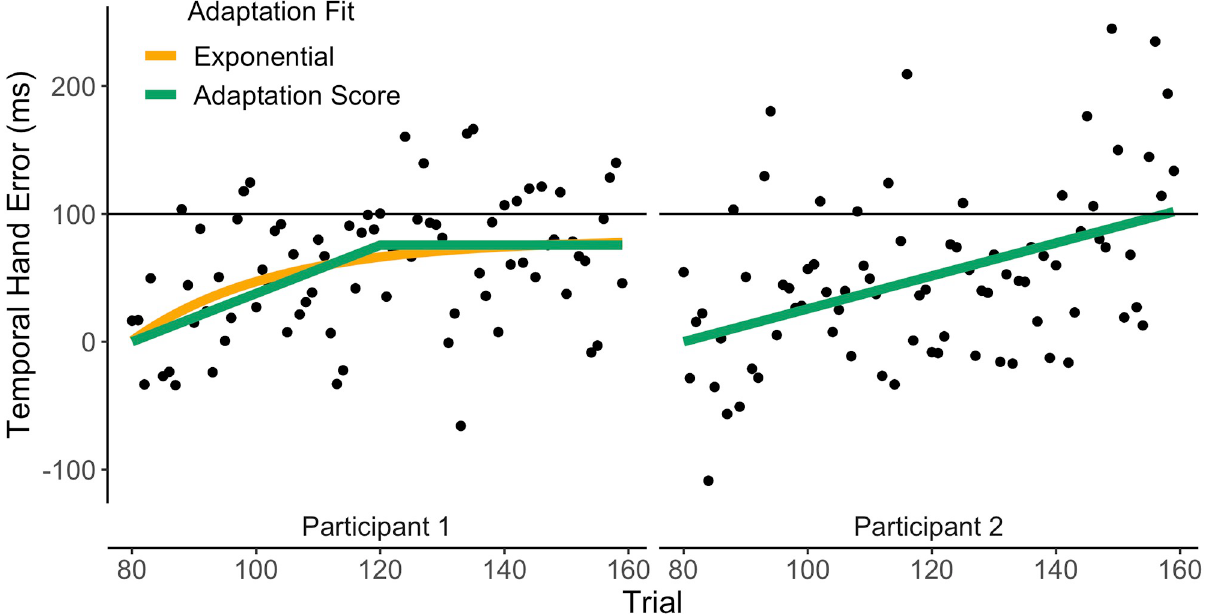
Fig 2. Adaptation score examples. The dots represent the moving averages (window = 4 trials) of two example participants. In order to calculate the Adaptation Score, the slope (a) and asymptote (b) were normalized across subjects and then summed for each participant. For P1 we were able to fit an exponential function, while for P2 the adaptation an exponential could not be